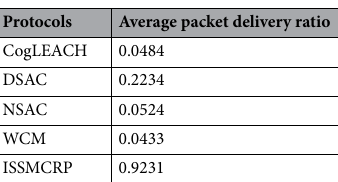
Table 4. Comparison results of average packet delivery